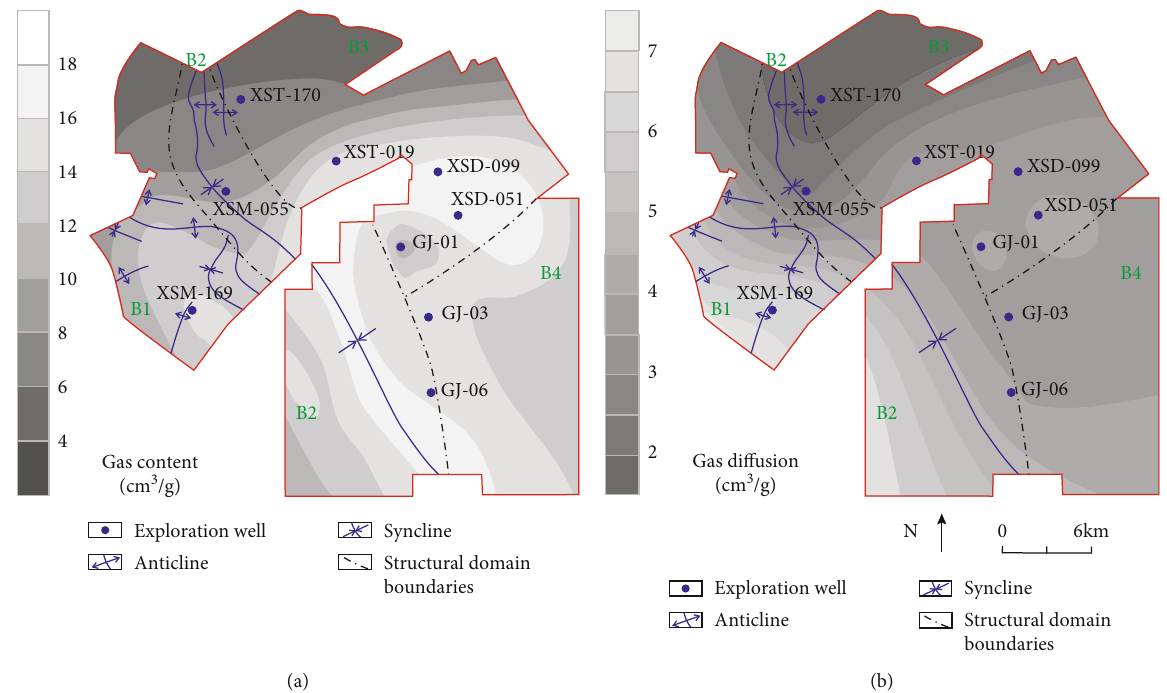
Figure 15: Distribution characteristics of gas content (a) at the end of substage VI